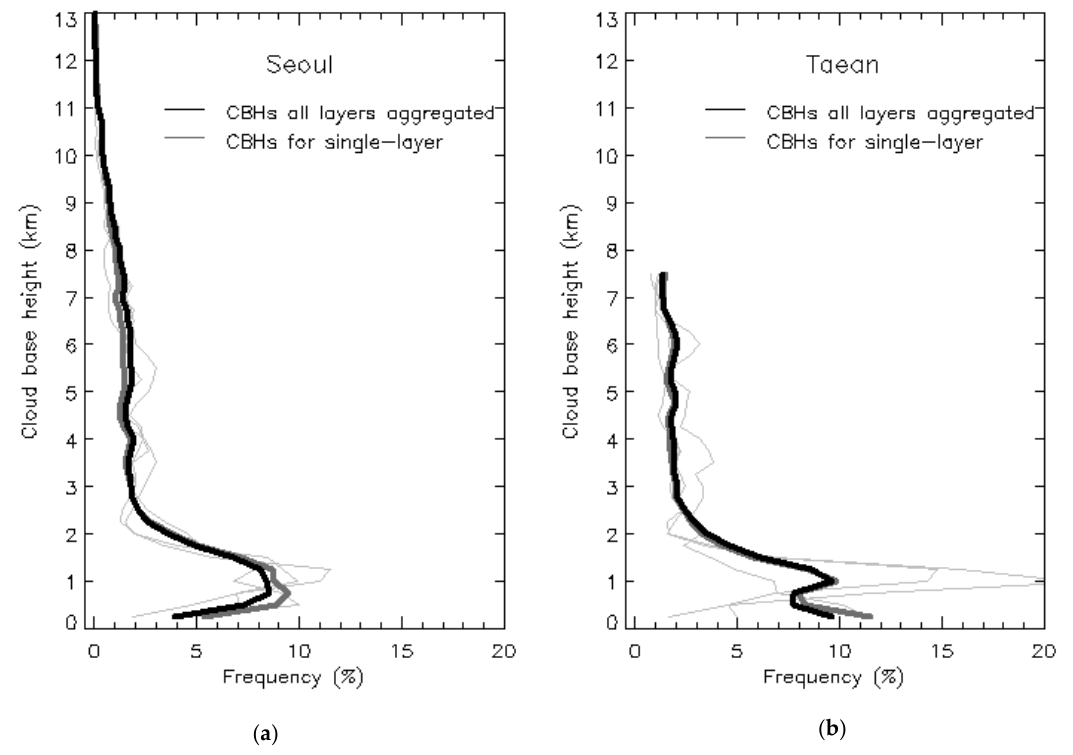
Figure 5. Frequency distributions of aggregated cloud base heights (CBHs) for all layers (bold black) and a single layer (bold gray) retrieved by the ceilometers at ( a ) Seoul and ( b ) Taean during a period 2017–2019. Thin vertical thin gray lines represent the annual averages.